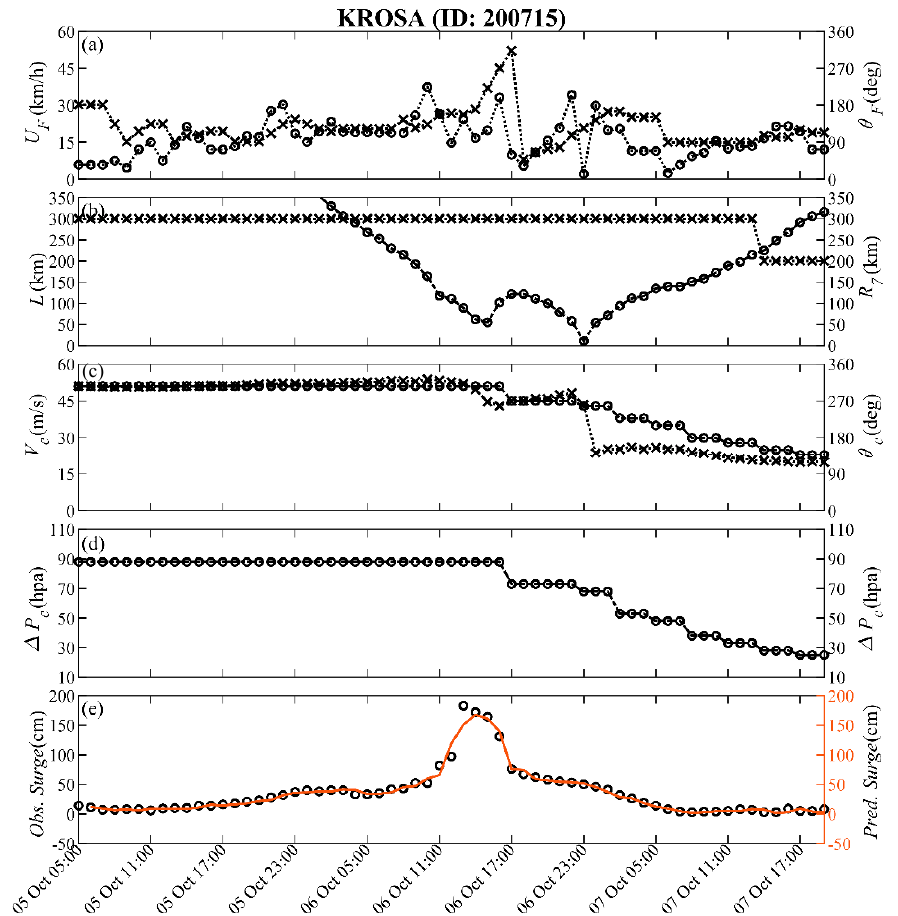
Figure 3. Temporal variations of typhoon parameters and storm surge at Longdong during Krosa event (training): ( a ) forward speed (circle) and forward angle (cross); ( b ) relative distance (circle) and radius of typhoon (cross); ( c ) wind speed (circle) and relative angle (cross); ( d ) central pressure deficit (circle); ( e ) observed (circle) and predicted (red lines) storm surges. Table 3. Assessment of different lead-time surge predictions during Krosa event (training). Lead Time (h)